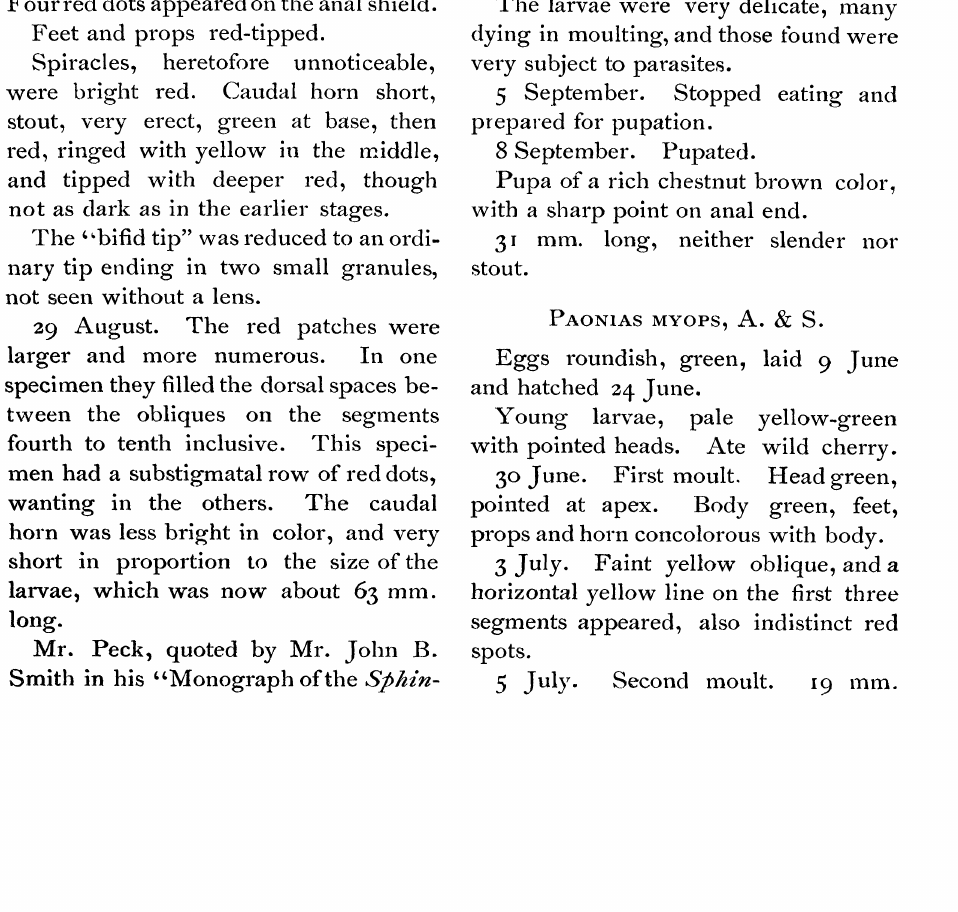
horizontal lines confined to the